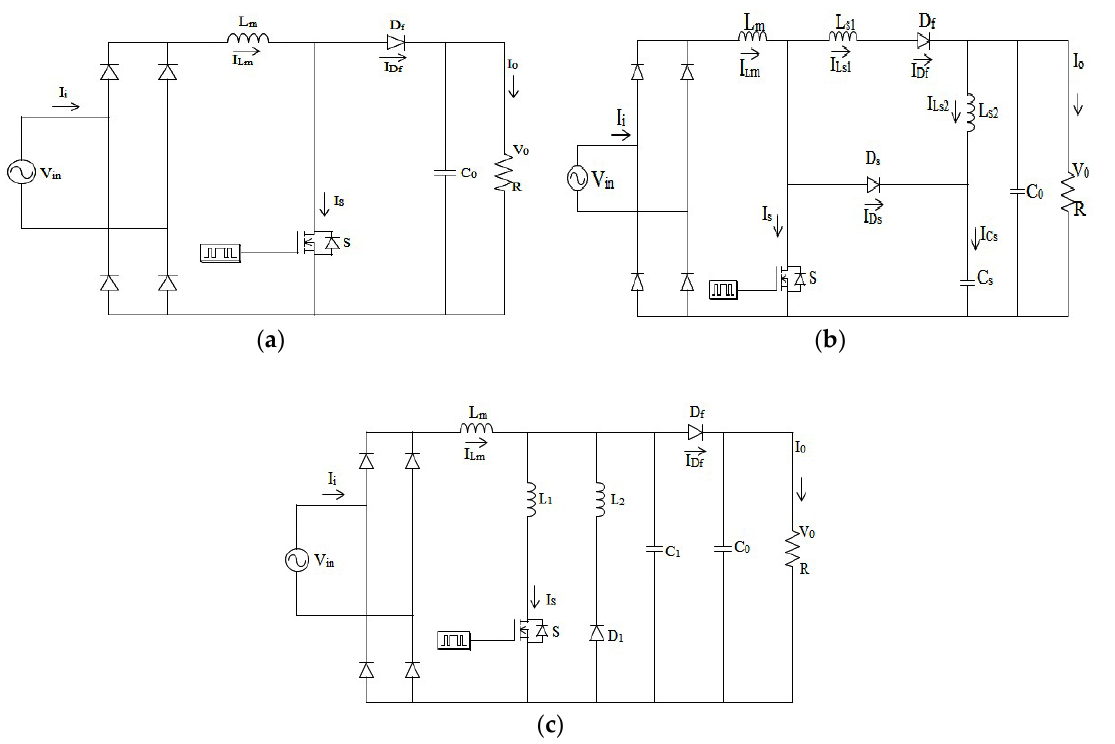
Figure 1. Existing ac ‐ dc Boost Power Factor Correction (PFC) Topologies. ( a ) Conventional ac ‐ dc Boost PFC Converter; ( b ) ac ‐ dc Boost PFC Converter Passive Snubber [33]; ( c ) ac ‐ dc Boost PFC Converter with Passive Snubber [34].